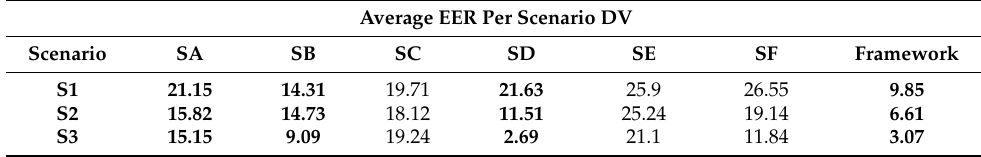
Table 15. Average EER per scenario DV.